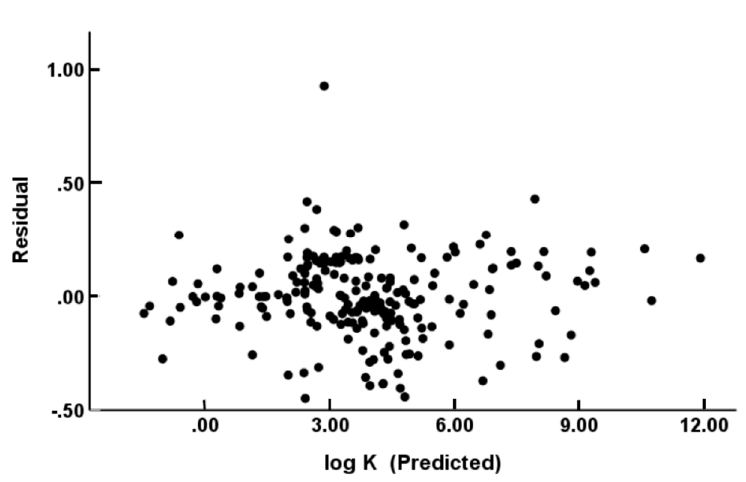
Figure 3. Residual graph for the log P PDMS-water correlation, Equation (11), for PDMS.